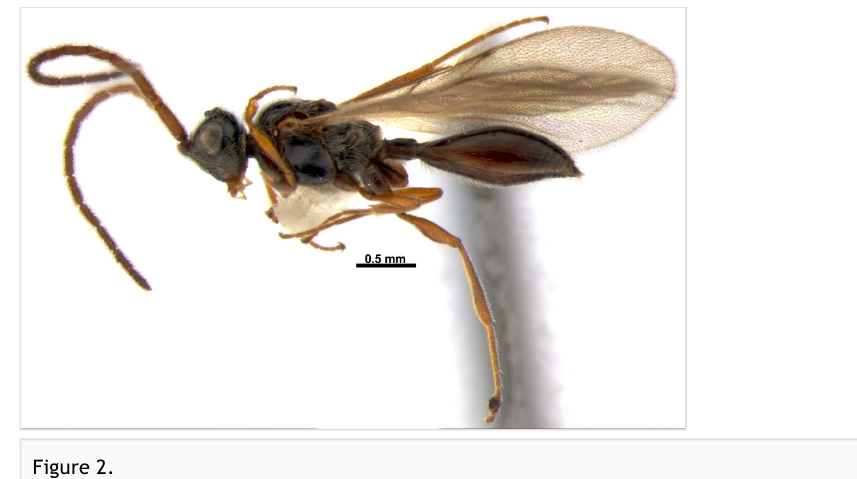
Acanospilus heterocerus Haliday, male. Habitus in lateral view.